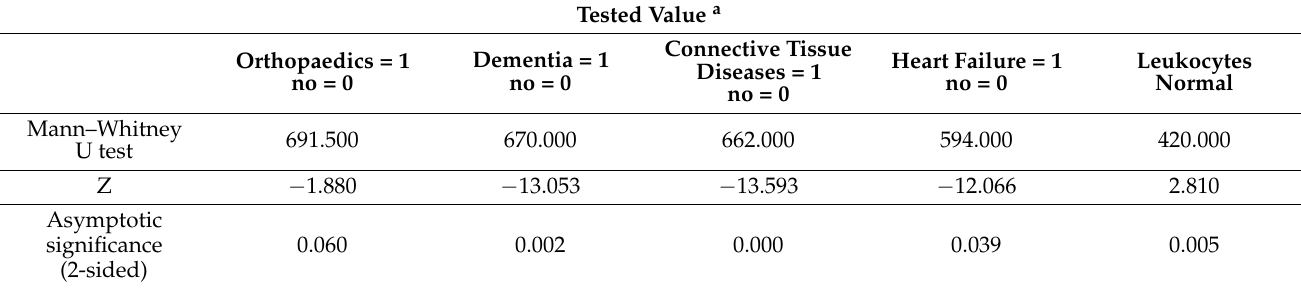
Table 5. Ranking of traits for their influence on the swab result, established with a Mann–Whitney U